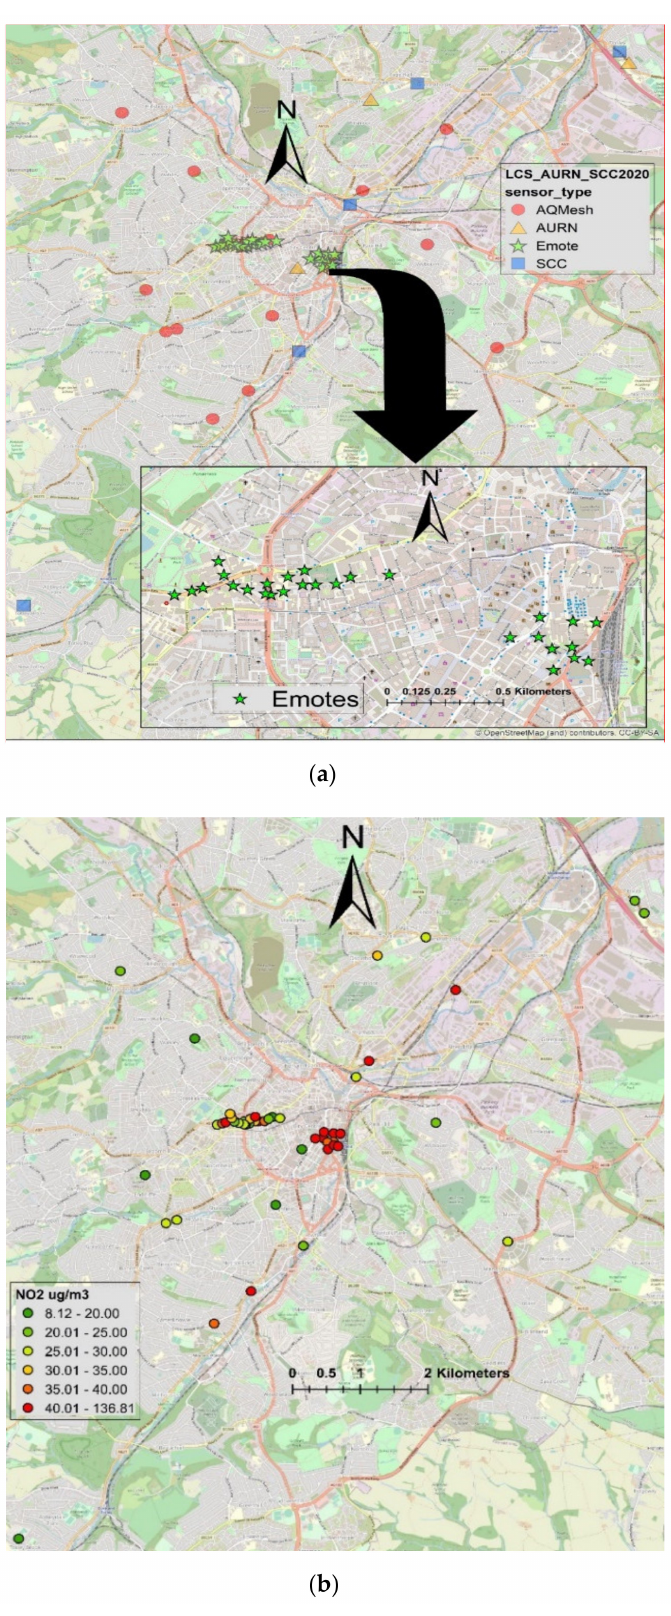
Figure 2. ( a ) The locations of air quality monitoring stations (AQMSs) in Sheffield; ( b ) annual mean NO 2 levels ( µ g/m 3 ) measured by low-cost sensors (LCSs) and Automatic Urban and Rural Network (AURN) and Sheffield City Council (SCC) AQMSs in Sheffield from August 2019 to September